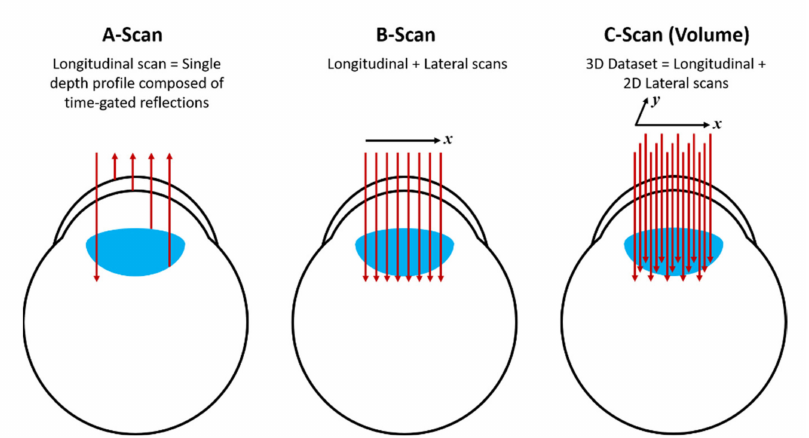
Figure 5. Diagram showing the A-scan, B-scan and C-scan obtained from the OCT